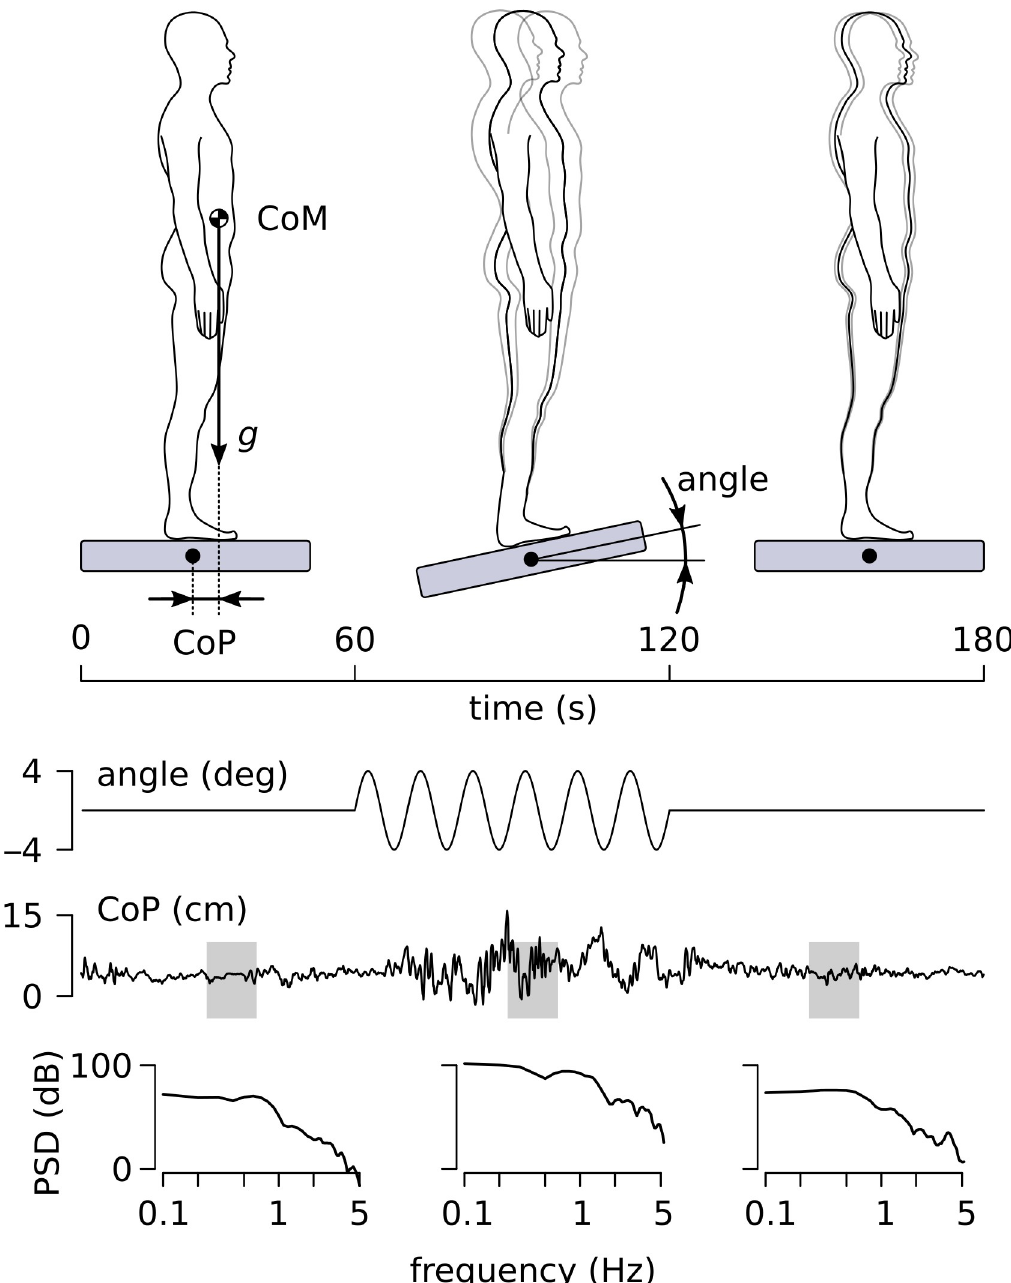
Fig 1. Experimental design and posturographic measurements. The three phases of the experiment (baseline, perturbation, and return) are shown in the upper panel. The time courses of the angle of the platform (for the specific case of 0.1 Hz) and of the anterior/posterior variation of the CoP are shown in the middle panel. Examples of the PSD for individual analysis windows in each phase, corresponding to the places indicated by gray rectangles, are shown in the bottom panel. was justified as we observed that the spectral amplitude dropped 60 dB between 0.01 Hz and 5 Hz, on average, across all conditions and participants (S1 Fig). Each PSD represents the spec- trum at the time instant corresponding to the center of the window, such that, for instance, the window spanning from 0 to 10s yields the PSD for t = 5s. Each PSD is represented by a